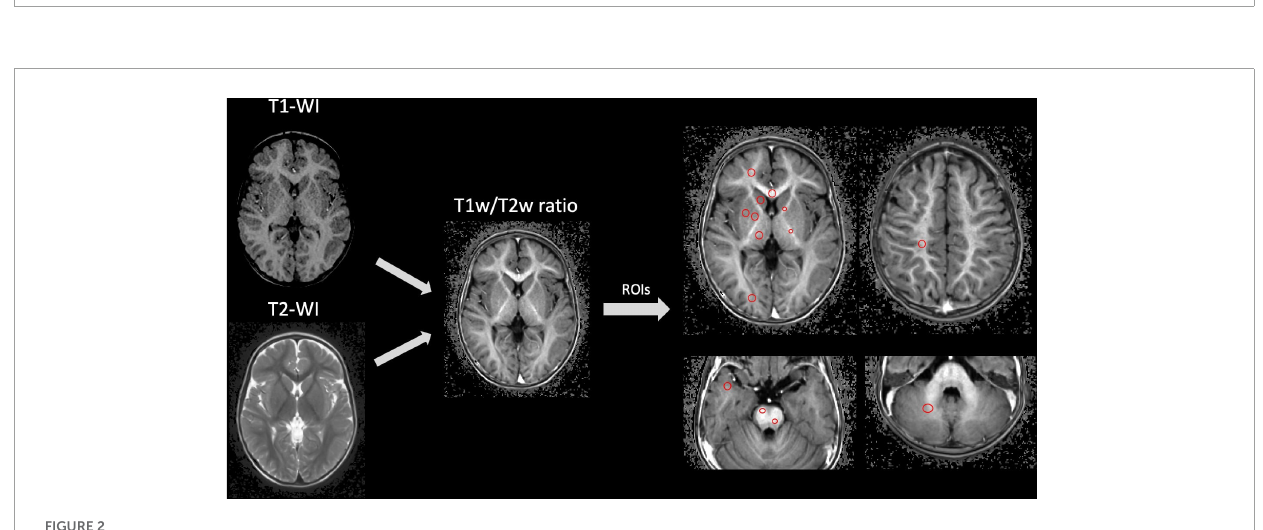
FIGURE2 Schematic illustration of MRI data postprocessing.